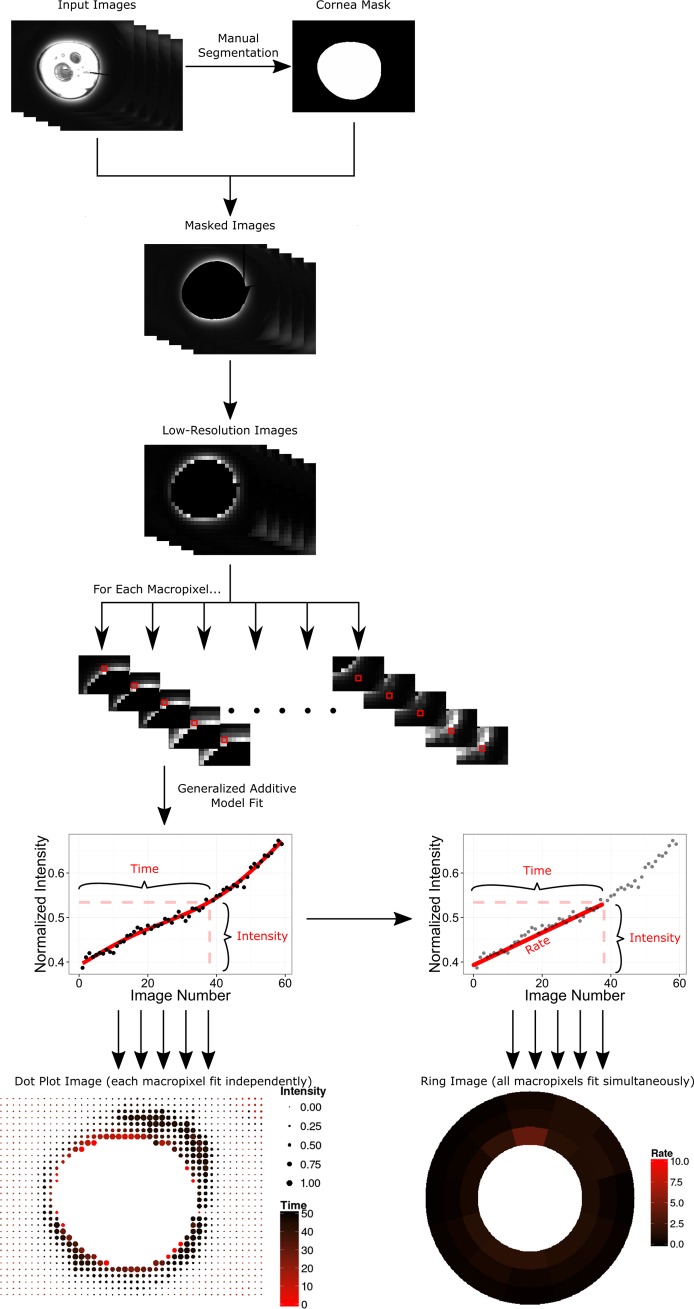
Image processing pipeline performed by the eye-canalogram R statistical analysis package.The left lower part of the figure shows how individual fits were generated to create a dot plot image–a single model fit was used for each macropixel. The lower right figure shows how filling rate was computed to create ring plots in which one global model fit was used for the entire plot.